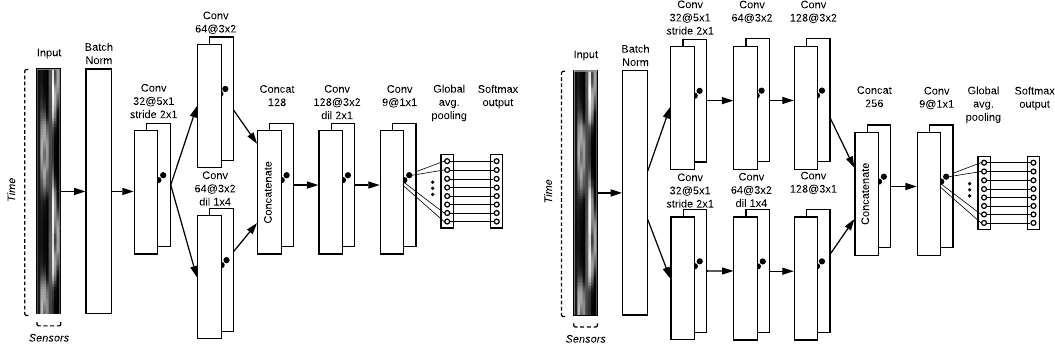
Figure 9. Parallel Branch Early fusion convolutional neural network (PBEF-CNN) model concatenating the structural information from spatially neighboring electrode is shown on the left side. The right architecture investigated the performance of the model by first maintaining the separated low-level feature extraction and concatenate the classification at the final stage. We name this structure the Parallel Branch Late Fusion convolutional neural network